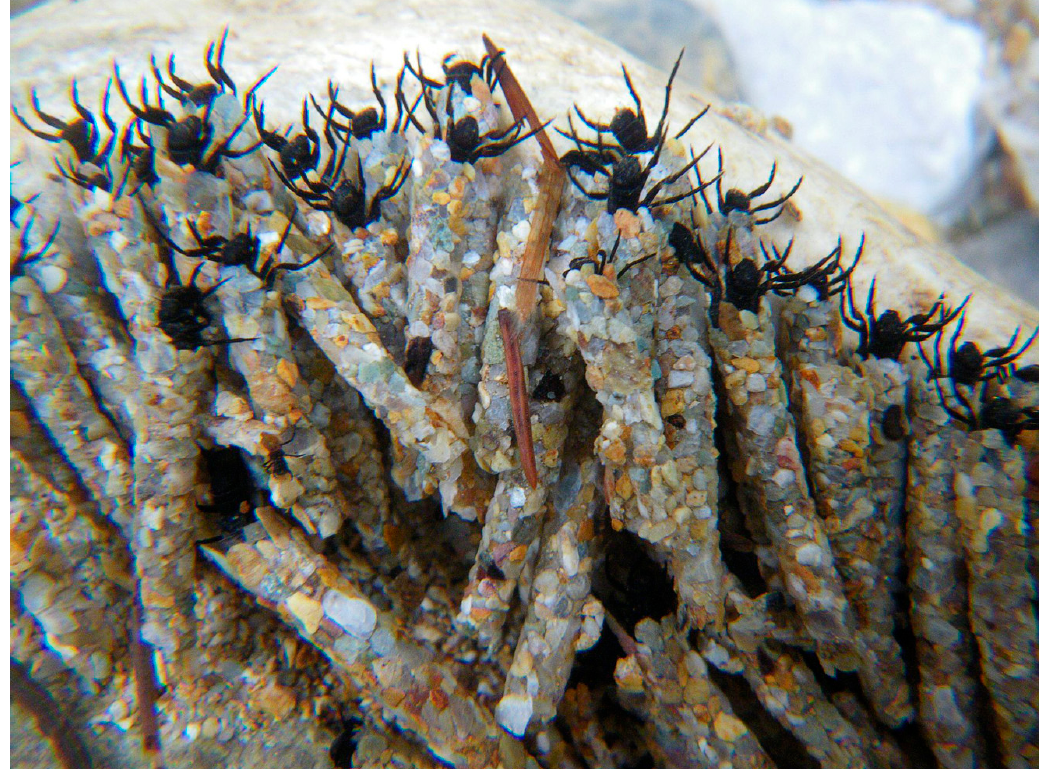
Figure 12. Larvae of Allogamus auricollis (F.J. Pictet, 1834) (Plenitentoria: Limnephilidae) filtering FPOM with their hairy legs. © W. Graf.